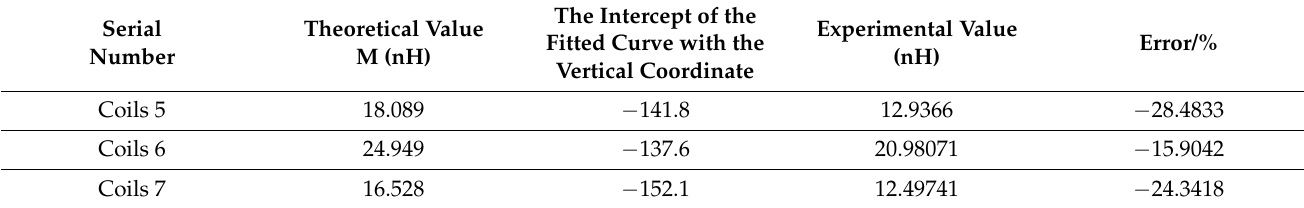
Table 6. Comparison of mutual inductance coefficient measured by experiment and theoretical value of coil